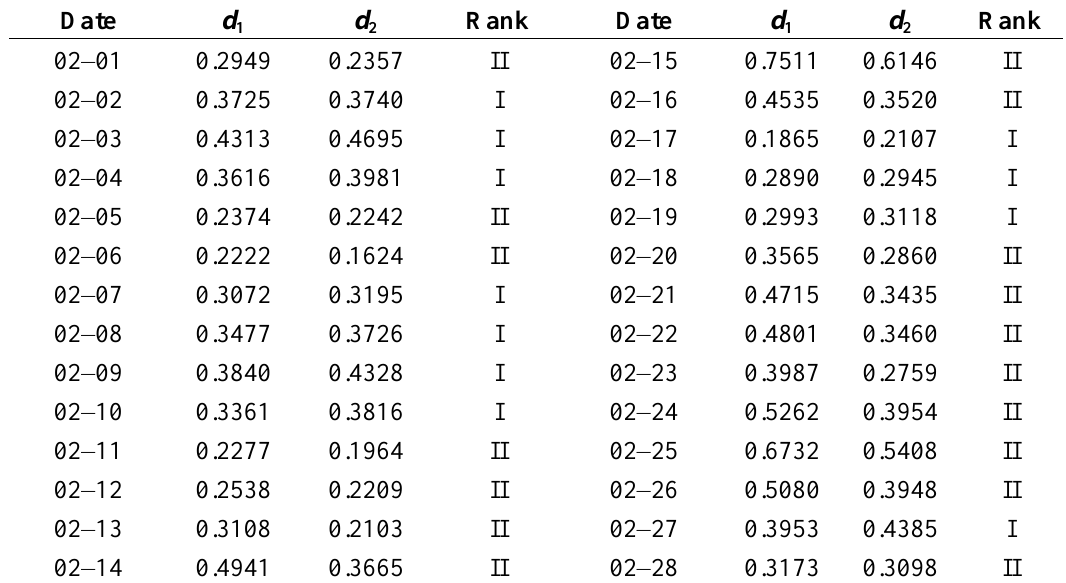
Table 5. Evaluation results based on Ambient Air Quality Standards (GB 3095-2012).